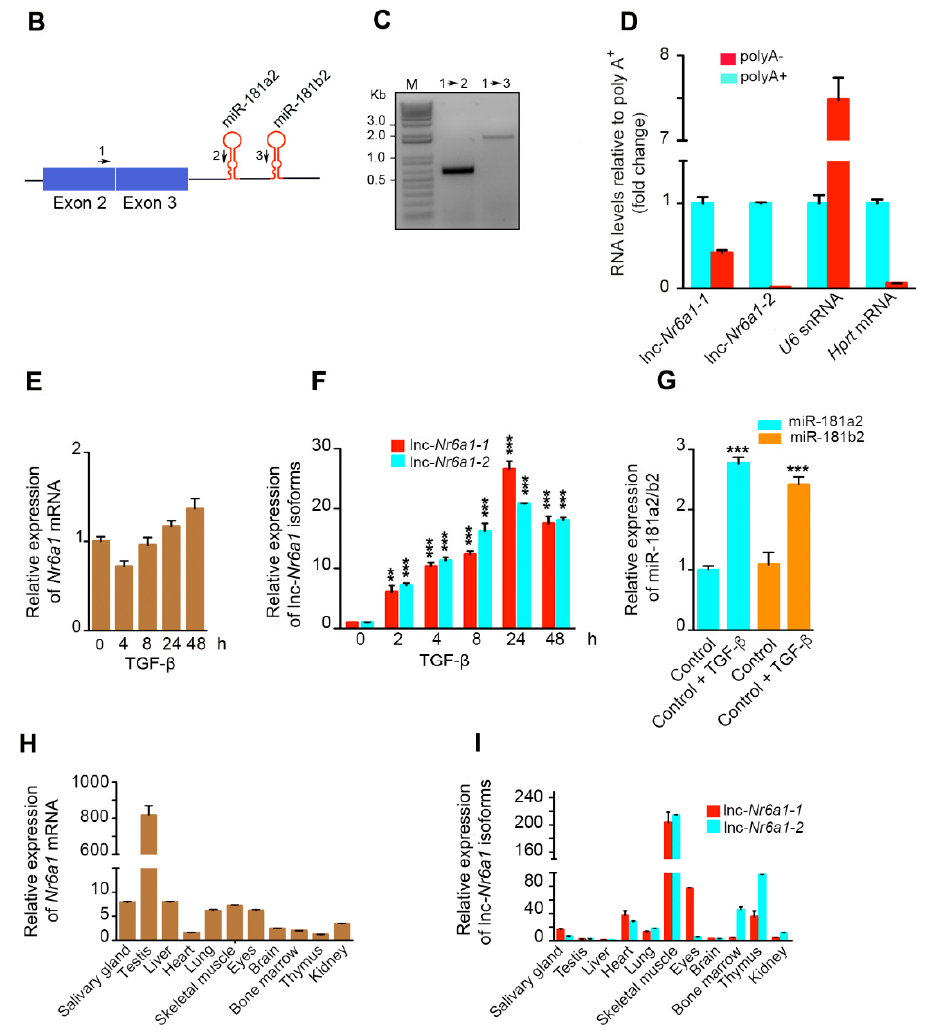
Figure 1. Genomic context and expression profiles of Lnc-Nr6a1 and Nr6a1 genes. ( A ) Schematic illustration of the genomic location and transcript structure of the Lnc-Nr6a1 gene embedded within the third intron of the Nr6a1 gene. The annotated nascent and processed transcripts of Lnc-Nr6a1 (lnc- Nr6a1-1 and lnc- Nr6a1-2 ) and lnc-pri-miR-181a2/b2 are shown. The red arrows indicate the transcription orientation. ( B ) Schematic representation of spliced lnc-pri-miR-181a2/b2 transcript and ( C ) electrophoretic gel showing PCR products generated with a forward primer located in exon2 and reverse primers located in miR-181a2 and mir181b2, respectively. ( D ) Rate of poly(A − ) RNA relative to poly(A + ) RNA for the indicated transcripts, quantified by RT-qPCR. ( E ) Relative levels of Nr6a1 mRNA in cells treated with TGF- β at the indicated times. Experiments were performed in triplicate samples and error bars represent S.D. ( F ) Relative levels of lnc- Nr6a1 isoforms in cells treated with TGF- β at the indicated times. ( G ) Expression of miR-181a2/b2 in cells treated with TGF- β for 24 h. Experiments were repeated twice in triplicate samples; error bars represent S.D. ( H , I ) relative expression of Nr6a1 mRNA and lnc- Nr6a1 isoforms, respectively, in a broad range of adult mouse tissues. Results are presented relative to a fixed reference sample (thymus and liver in ( H , I ), respectively). Experiments were performed in triplicate samples; error bars represent S.D. *** p < 0.001, ** p < 0.01 by two-tailed Student’s t